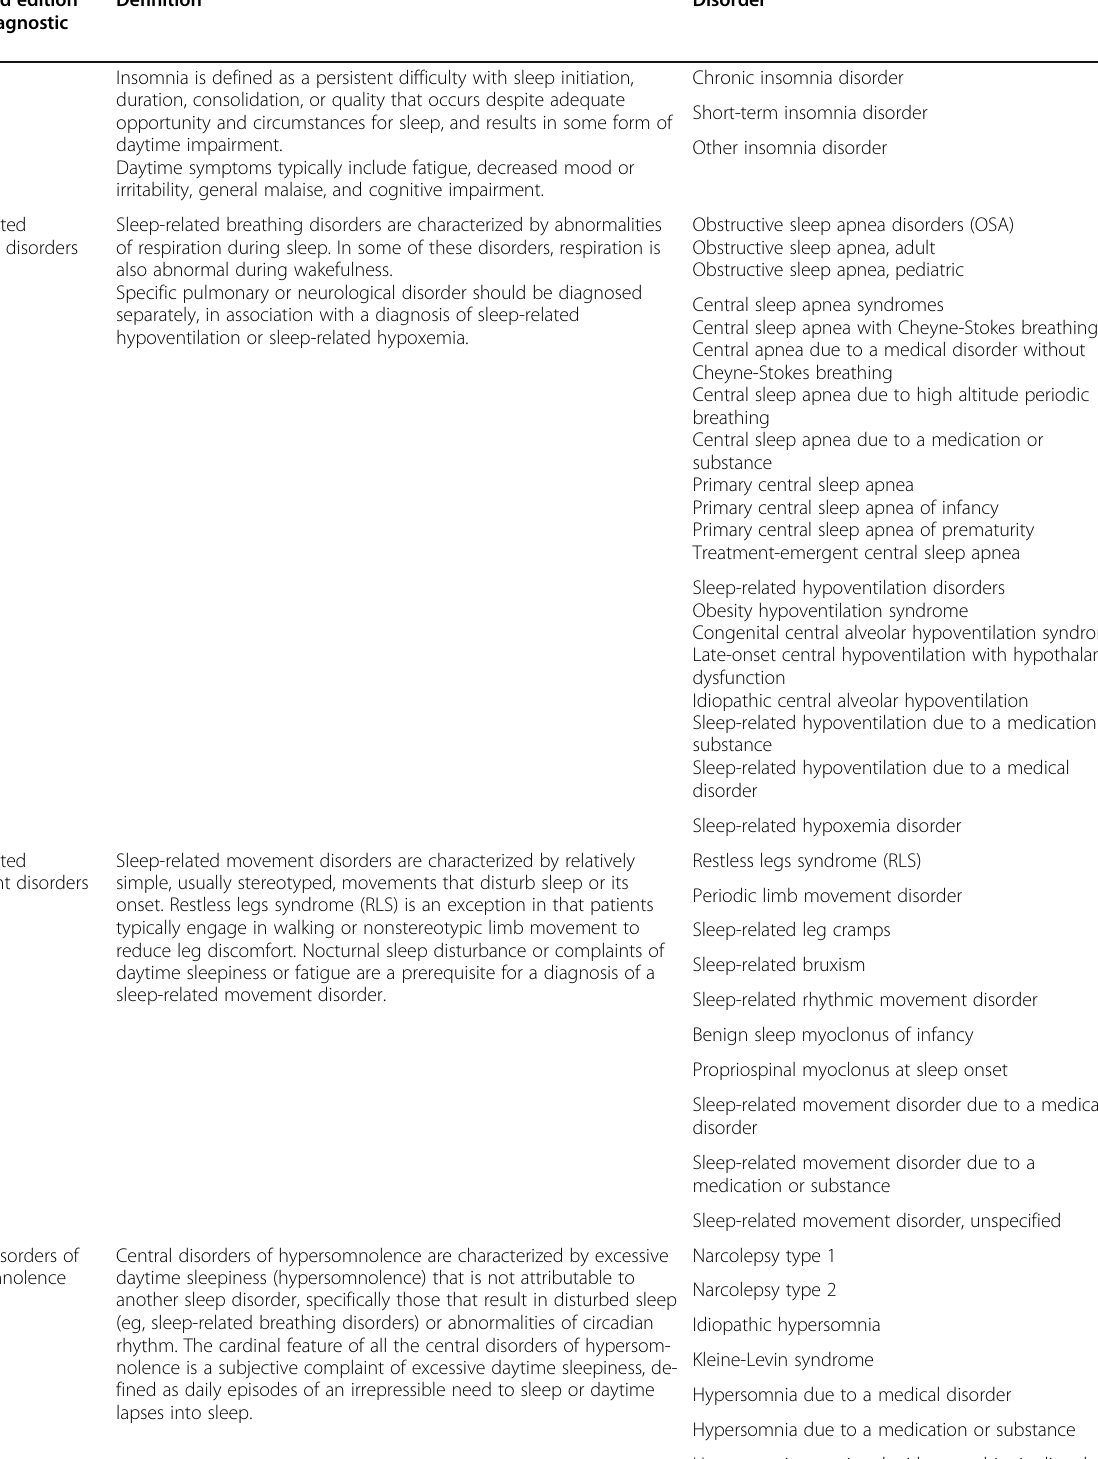
Table 1 Sleep disorders according to the International Classification of Sleep Disorders – third edition (Adapted from American Academy of Sleep Medicine. International Classification of Sleep Disorders. 3rd ed. Darien, IL: American Academy of Sleep Medicine; 2014 and from Sateia MJ. International classification of sleep disorders-third edition: highlights and modifications. Chest. 2014;146:1387 –